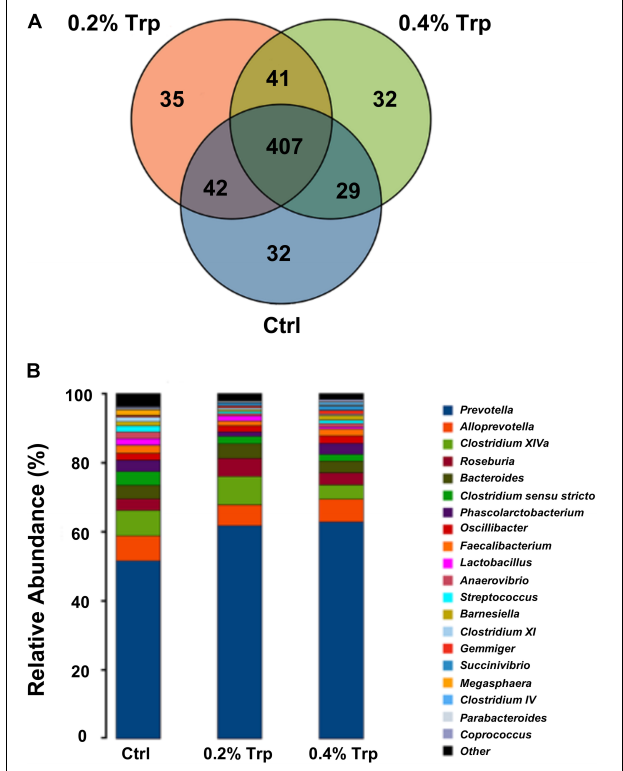
FIGURE 1 | Changes in operational taxonomic units (OTUs) and classification abundance of bacteria. (A) The Venn plot of the OTUs in different treatment groups ( n = 8). (B) The relative abundance of the dominant bacteria (percentages) in the cecum contents of weaned piglets at the genus level ( n = 8). Ctrl, control group; Trp,